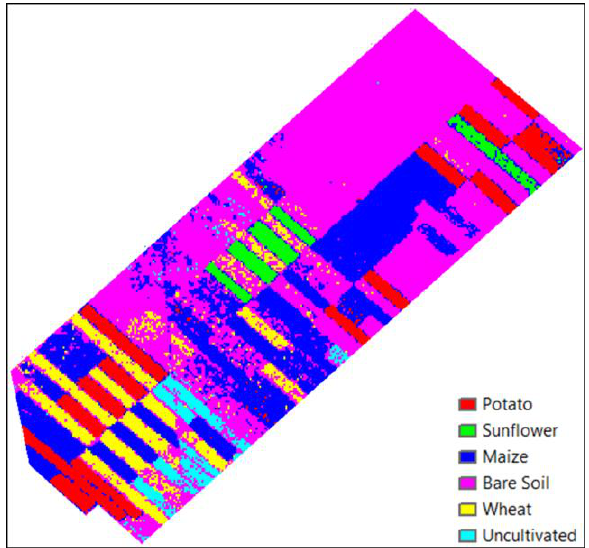
Figure 6. Crop classification of SAR dataset (MLC)